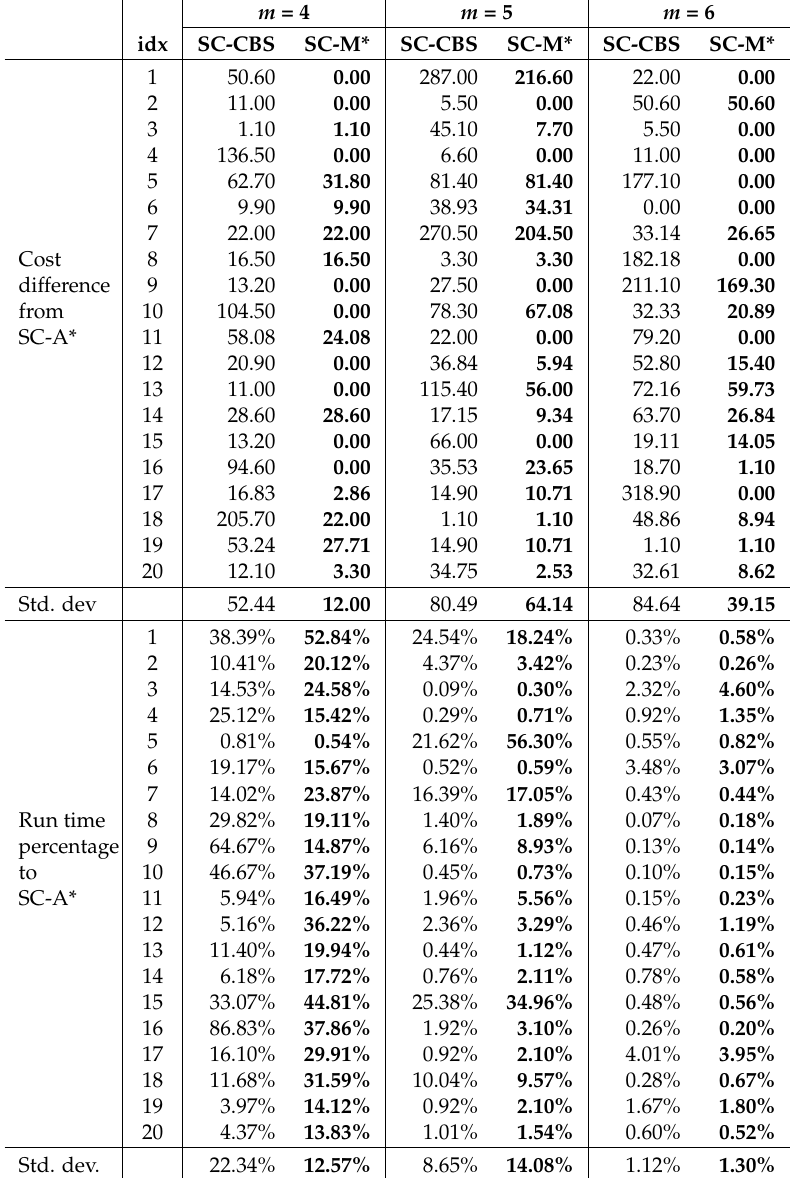
Table 3. Results of the path cost